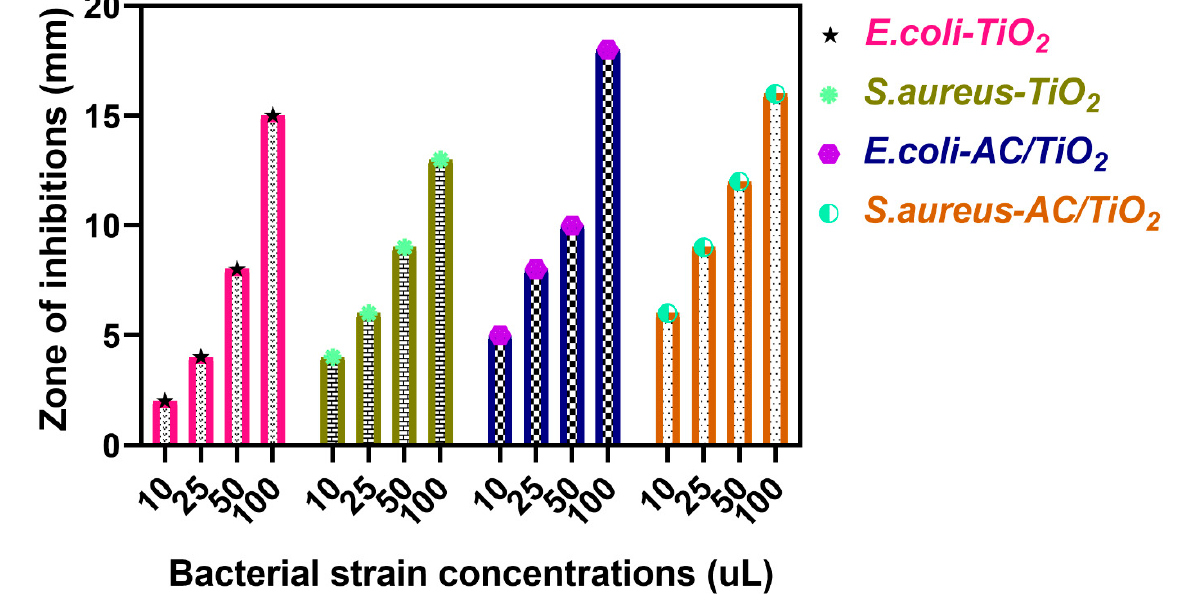
Figure 7. Zone of inhibitions of TiO 2 and AC/TiO 2 nanoparticles against various pathogens.